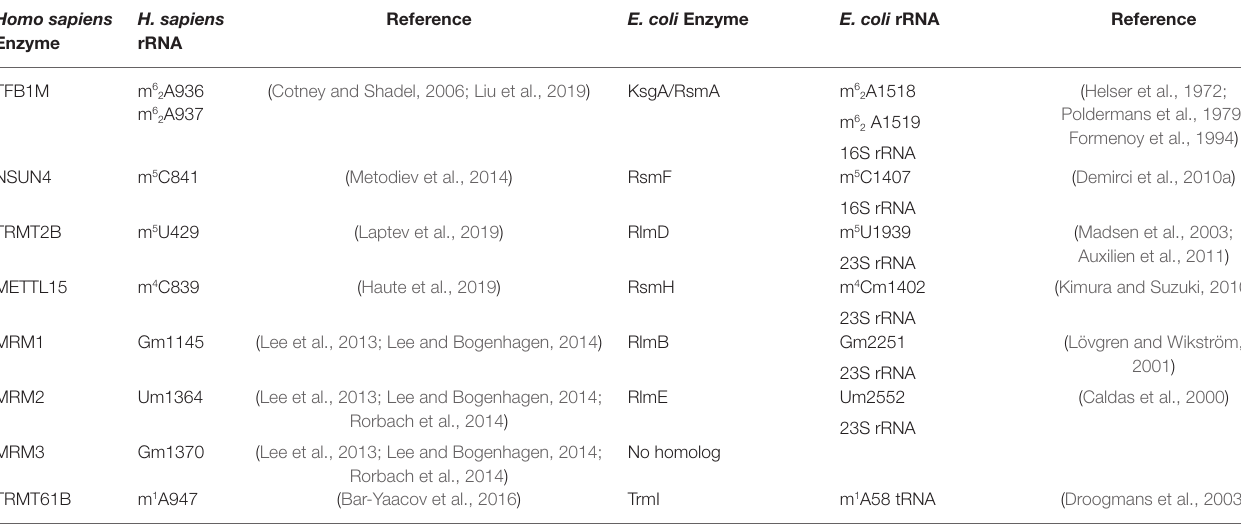
TABLE 2 | Mitochondrial rRNA methyltransferases, corresponding bacterial homologs, and modified RNA residues. Homo sapiens